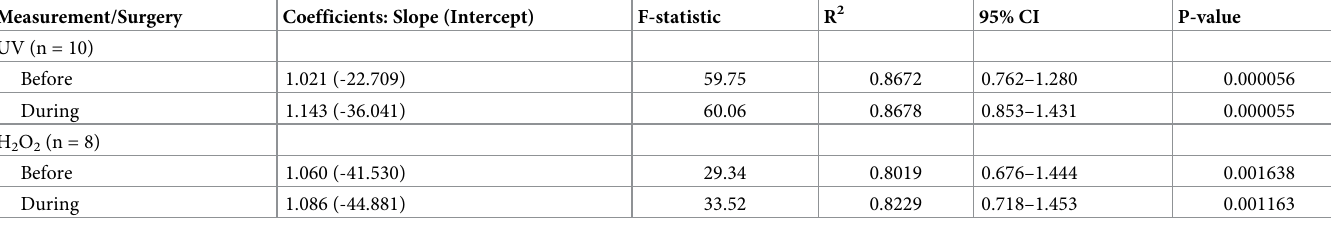
Table 2. A correlation on glucose levels between the anterior chamber and blood in Study 1 subjects.